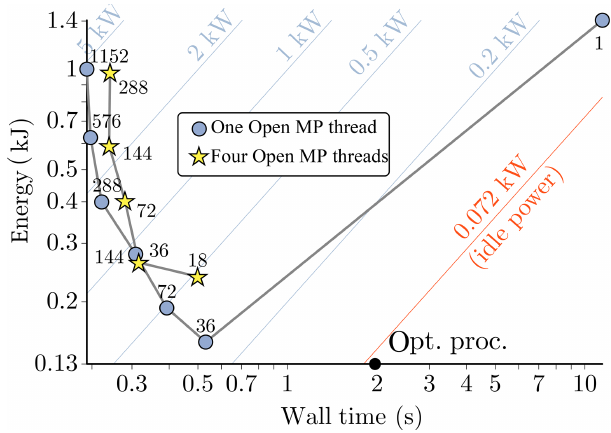
Figure 13. Log–log plot of the energy consumption vs. wall-clock time for the biFFT dwarf corresponding to the combination of one direct and one inverse transformation for 525 fields. Each data point is the result of averaging the outcome of two separate runs. Grey lines connect runs with the same number of OpenMP threads (one and four). Added are lines of constant power (light blue lines), in- cluding the power delivered by a node in the idle state (orange line). Indices next to each data point denote the number of MPI tasks. The black dot represents the estimate of the Optalysys optical processor when using a greyscale SLM. The performance of the optical pro- cessor at binary precision is much higher (not